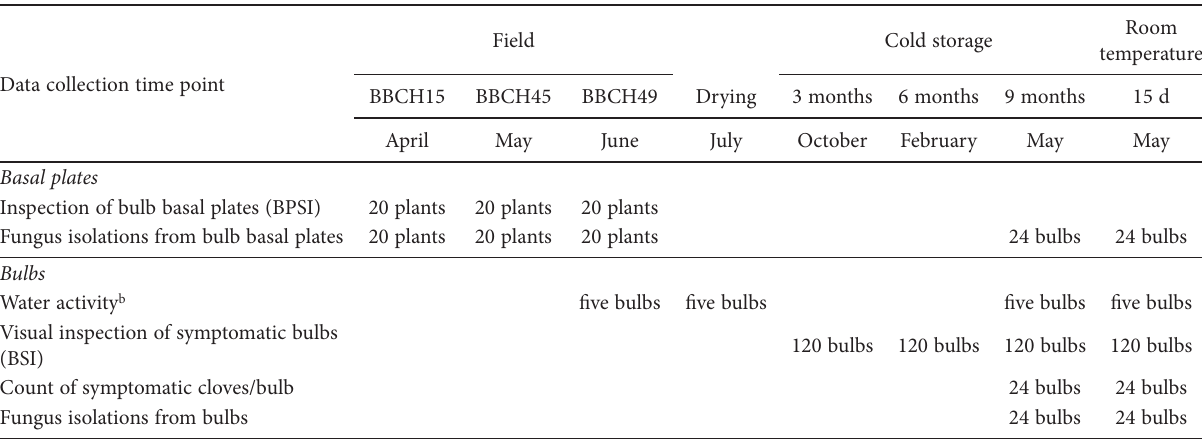
Table 2. Experimental scheme of garlic plant/bulb sampling time points in the production chain, from growth in the field through posthar- vest cold storage and delivery a